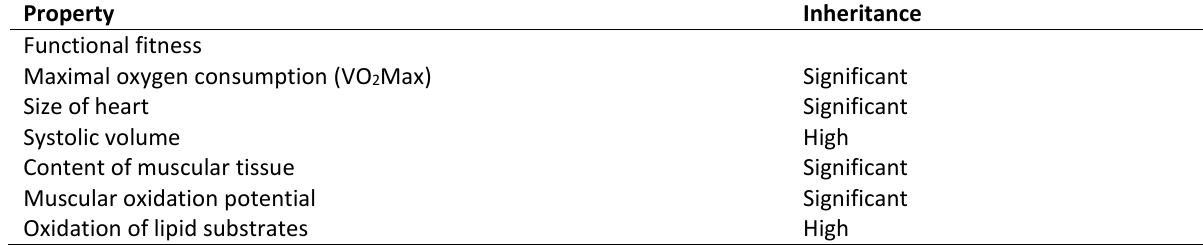
Table 4. Inheritance of morphological-functional and functional fitness